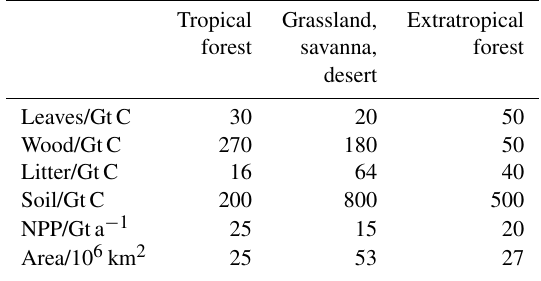
Table 1. Pre-industrial distribution of carbon storage among model land carbon pools as well as model net primary production for the three vegetation zones (see Chapin III et al., 2011, and citations therein). Tropical Grassland, Extratropical forest savanna, forest